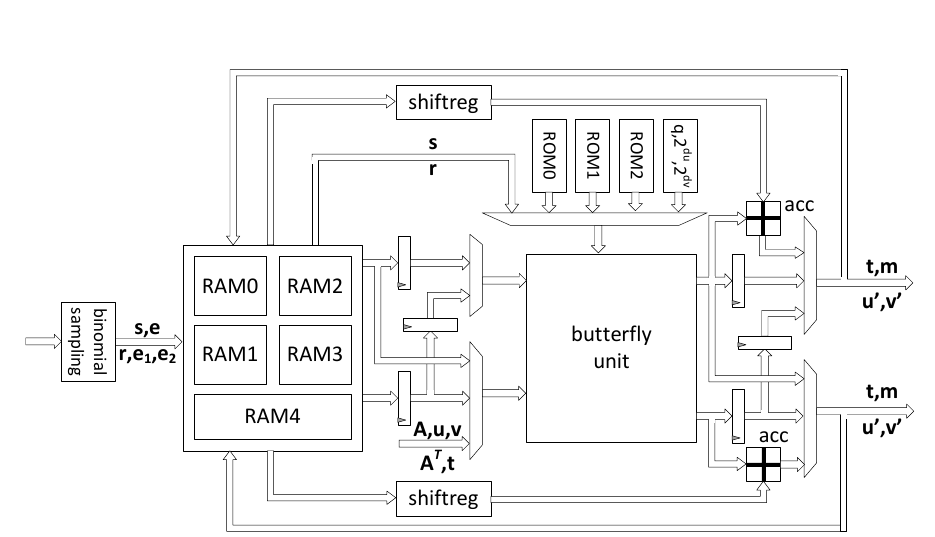
Figure 4: NTT structure, with symbols of intermediate values located above/under data path arrows correspond to data flow of server/client